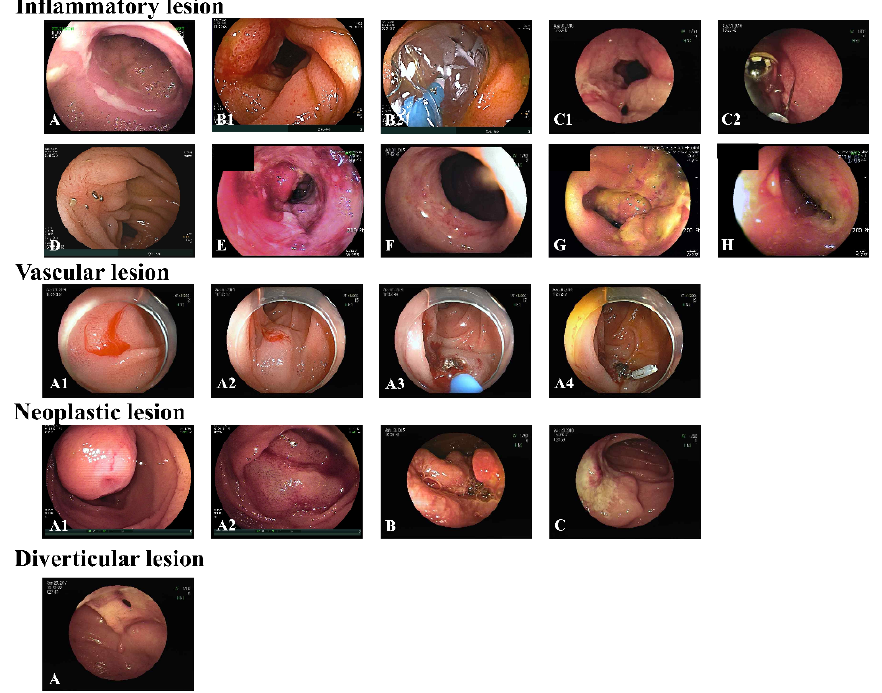
Figure 1. Endoscopic images of double-balloon enteroscopy. Inflammatory lesions: ( A ) Intestinal tuberculosis on mid-jejunum, ( B1 , B2 ) Crohn’s disease with luminal narrowing on mid-ileum, balloon dilatation, ( C1 , C2 ) Crohn’s disease with capsule retention, foreign body removal, ( D ) Postoperative stricture mid-jejunum, ( E ) Ischemic enteritis on distal ileum, ( F ) Cryptogenic multifocal ulcerous stenosing enteritis on proximal ileum, ( G ) Henoch–Schönlein purpura on proximal jejunum, ( H ) NSAID-induced enteropathy on distal ileum. Vascular lesions: ( A1 – A4 ) Dieulafoy’s lesion on duodenal 3rd portion, epinephrine injection, argon plasma coagulation, and hemoclipping. Neoplastic lesions: ( A1 , A2 ) Malignant gastrointestinal stromal tumor on proximal jejunum, tattooing before surgery, ( B ) Adenocarcinoma on proximal jejunum, ( C ) Burkitt’s lymphoma on distal jejunum. Diverticular lesion: ( A ) Meckel’s diverticulum on distal